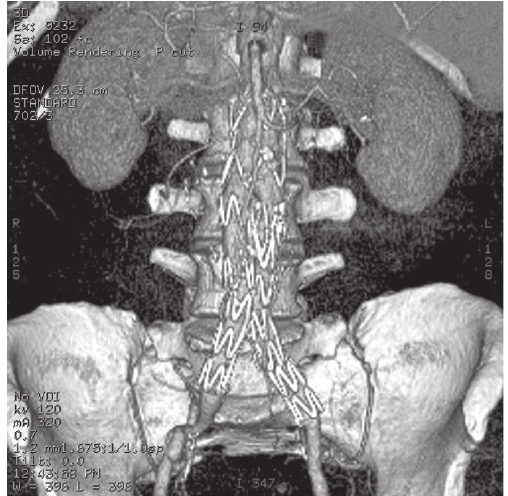
Fig. 2 - Angiotomografia de controle de paciente submetido ao implante de endoprótese bifurcada para correção de